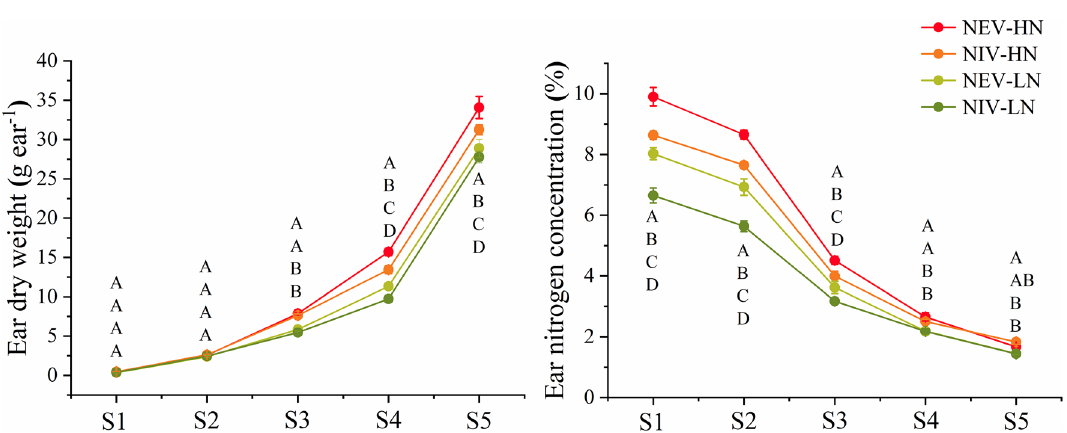
Figure 3. Dynamics of ear dry weight and nitrogen concentration during critical ear differentiation stages. Each point represents a replicate deriving from 2018 to 2019. HN high nitrogen conditions, LN low nitrogen conditions. The letter as indicates the difference between varieties at P < 0.05. From top to bottom, represent NEV-HN, NIV-HN, NEV-LN and